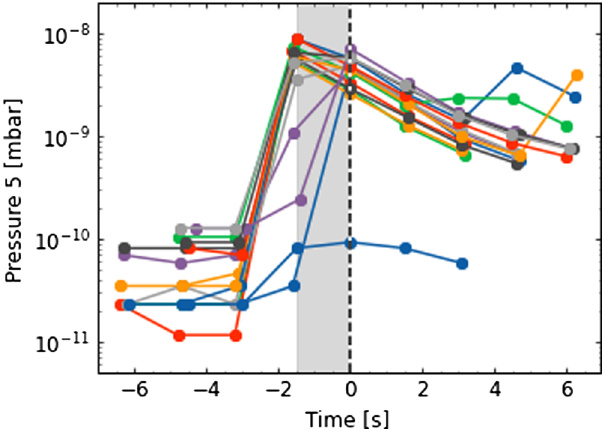
FIG. 11. Data samples of pressure 5, aligned to the interlock state of the test stand. The gray area represents the confidence interval, i.e., the window of time covering the previous 75 pulses in which the breakdown occurred. Data indicate that the pressure begins to rise before an interlock is triggered with the Faraday cup and the reflected traveling wave